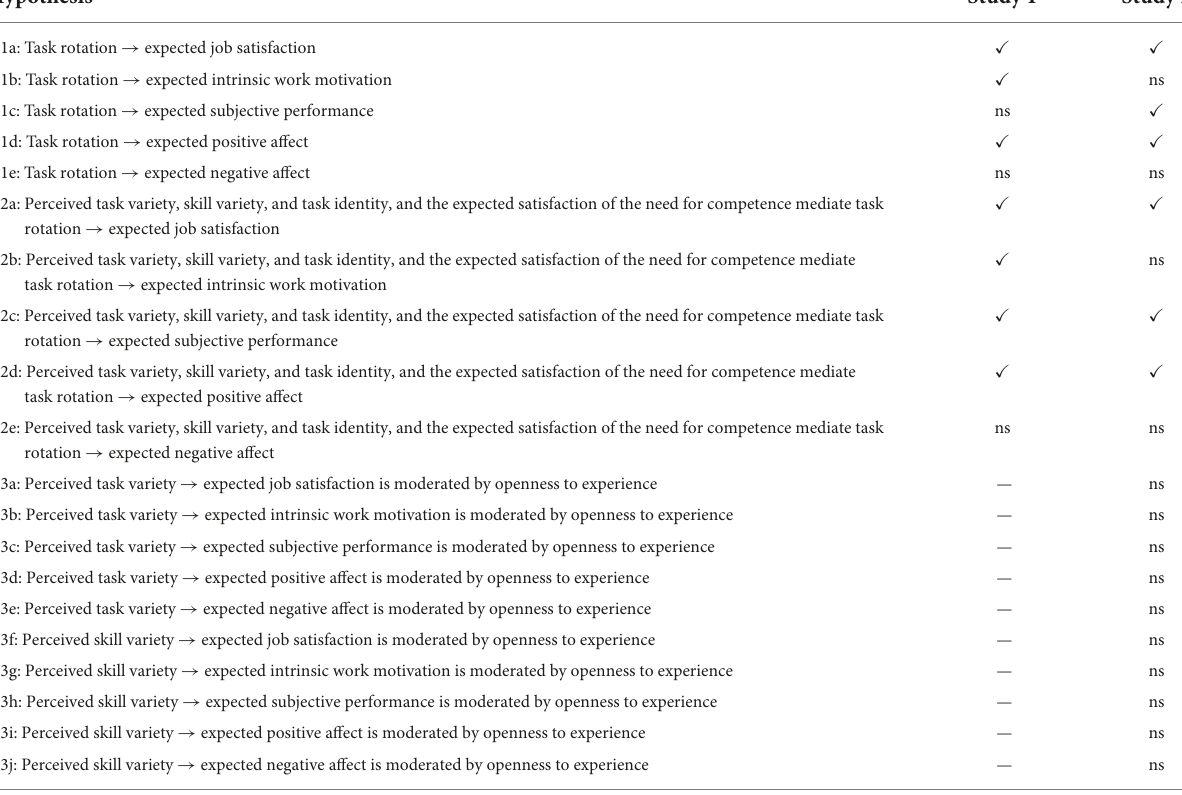
TABLE 4 Overview of supported and rejected hypotheses.